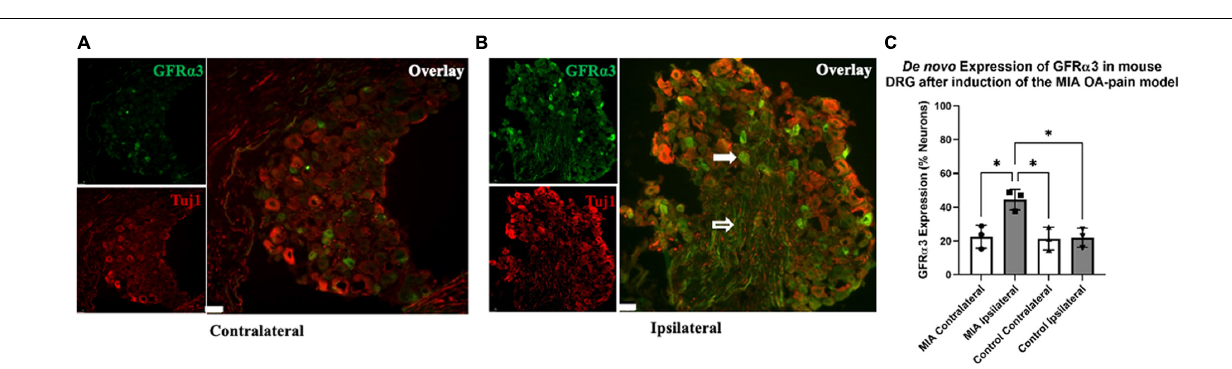
FIGURE 4 | De novo expression of GFR α 3 in MIA-induced mouse model of OA-pain. Contralateral (A) and ipsilateral (B) mouse lumbar 1–6 DRG were double immunostained with Tuj1 in red and GFR α 3 in green. The white filled arrow highlights a neuronal cell body that is positive for both Tuj1 and GFR α 3. The white unfilled arrow points to a nerve afferent that is positive for GFR α 3. The white marker bar represents 75 µ m. (C) Quantification of GFR α 3 normalized against a pan-neuronal marker (Tuj1) revealed an increase in GFR α 3 in mice injected with MIA. A total 10–13 sections from each side were counted for the number of neurons (Tuj1) and the number of neurons expressing GFR α 3. We found a significant difference in GFR α 3 expression between the MIA ipsilateral and MIA contralateral, saline ipsilateral, and saline contralateral lumbar DRG’s. Control ( n = 3) and MIA ( n = 3). Data are represented as mean ± SD (* p < 0.05). An ordinary one-way ANOVA with Holm-Sidak multiple comparisons